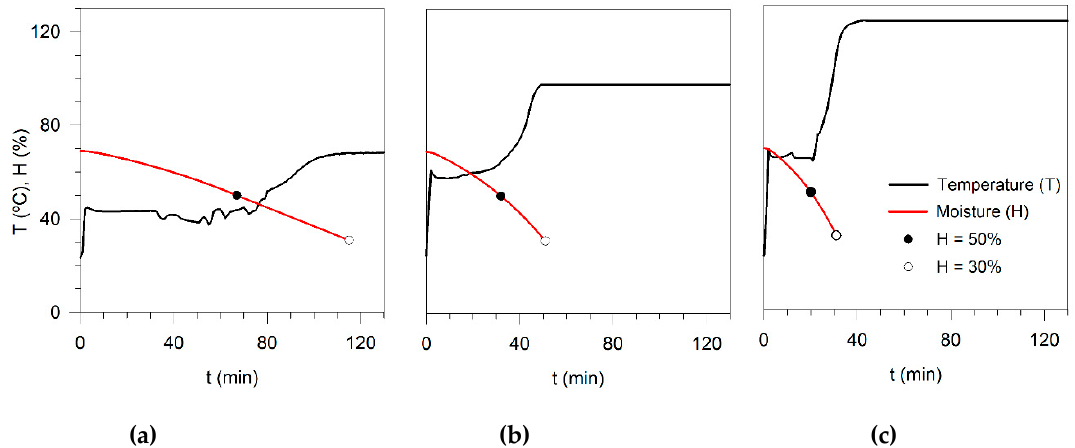
Figure 4. Temperature profiles inside the AD1.3 sample at a drying temperature of: ( a ) 70, ( b ) 100, and ( c ) 130 °C.